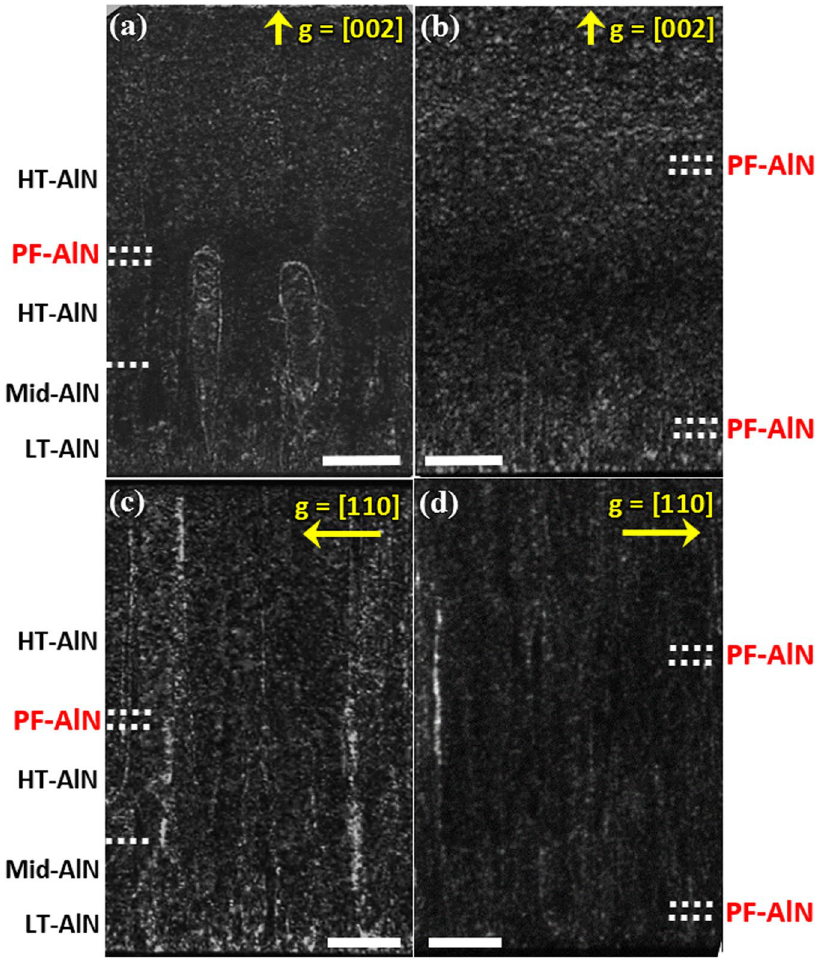
Figure 3. Cross-sectional dark-field TEM images of the AlN layers taken under two beam conditions. g = [002]: ( a ) the SPF sample and ( b ) the DPF sample. g = [110]: ( c ) the SPF sample and ( d ) the DPF sample. Dislocation bending is clearly seen in ( a ). Scale bars are 200